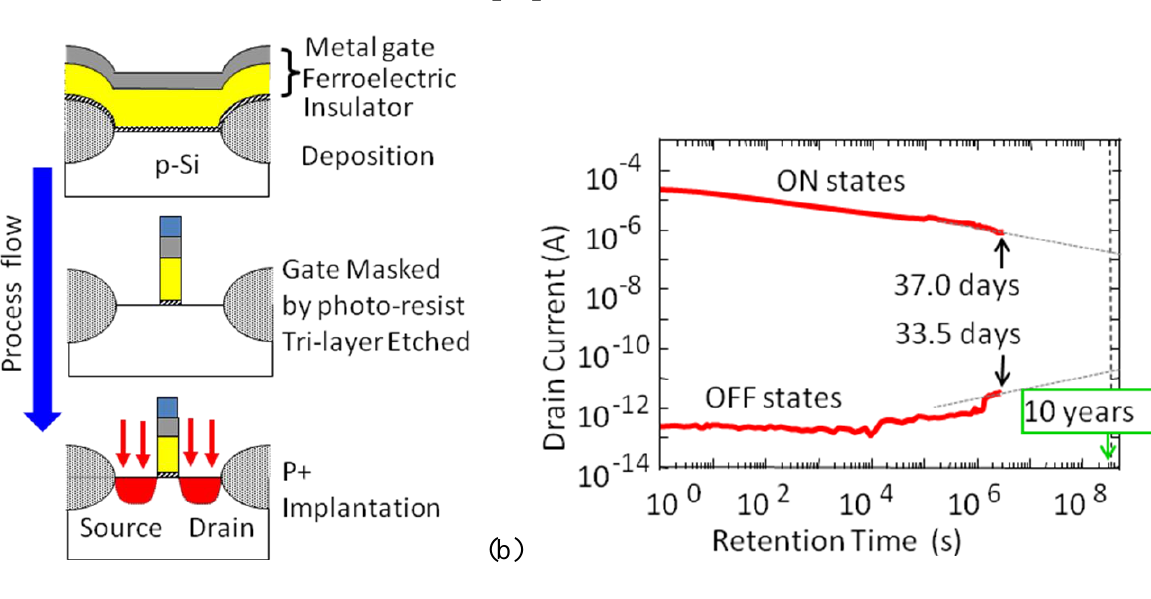
Figure 6. (a) Self-aligned-gate process for fabricating FeFETs; (b) Drain current retention of a self-aligned-gate Pt/SBT/Hf-Al-O/Si FeFET with L = 2µm. Respective curves for on- and off-states were measured over one month. Thicknesses of the SBT and Hf-Al-O were 420 nm and 12 nm. Modified from [28].